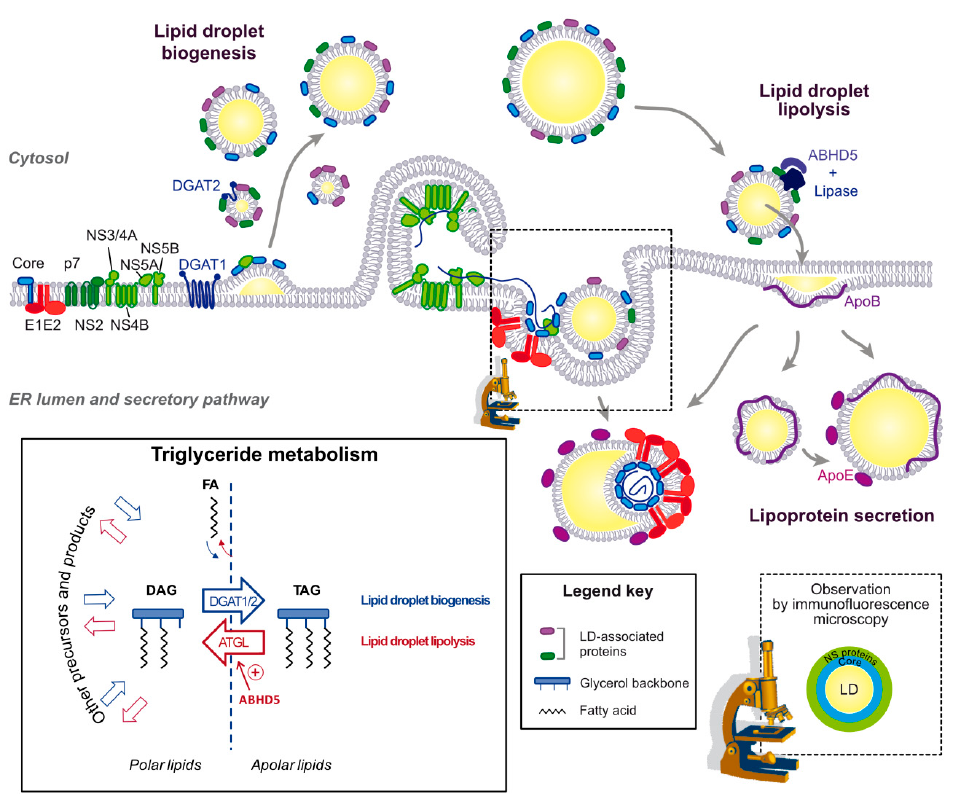
Figure 4. Model for HCV assembly and release. HCV morphogenesis likely occurs at contact